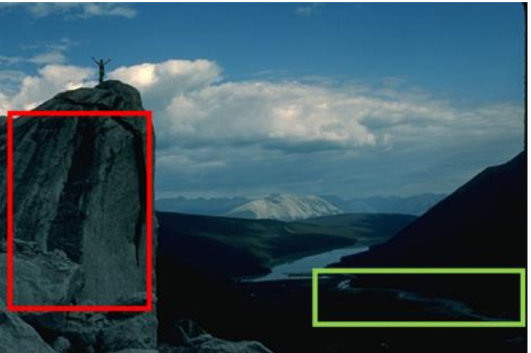
Figure 4. Input image with highlighted regions for detailed